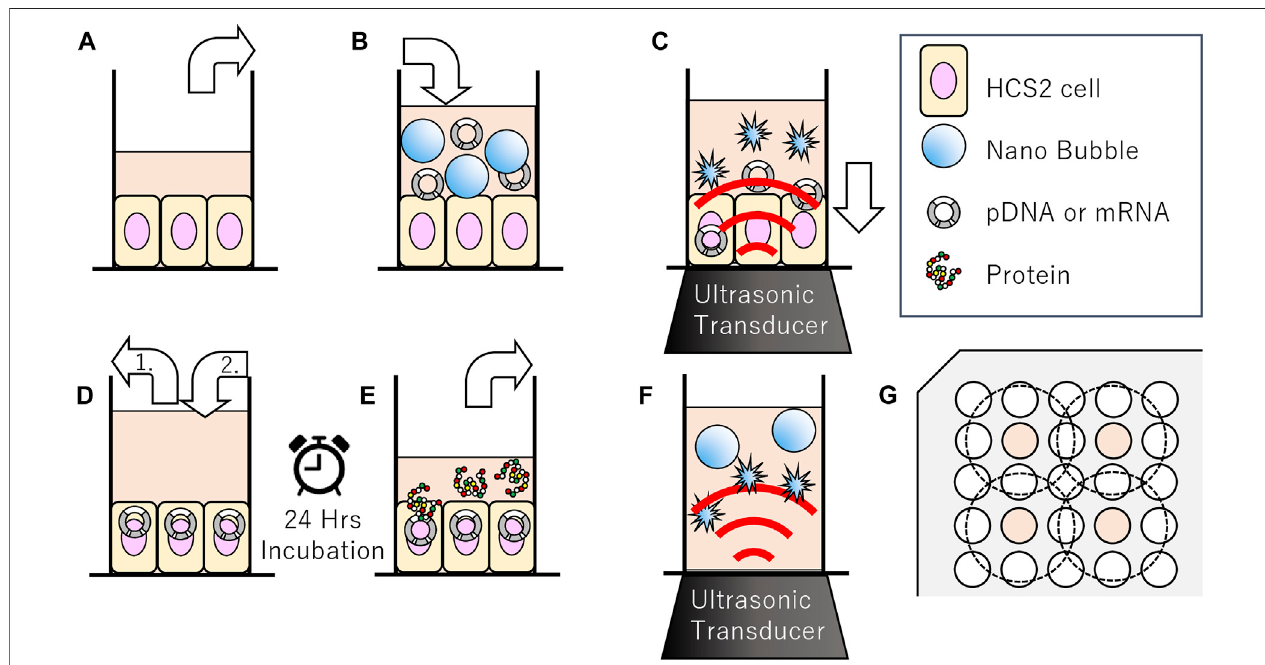
FIGURE 1 | Schematic representation of methods of sonoporation or sonication treatment to nanobubbles in 96-well plates. (A – E) Methods of sonoporation. (A) Removeincubationmediumfromwellof96multiwellplateseededwithHSC-2cells. (B) Fillwellswithmediumnanobubblesincluded. (C) Genetransfectionbyultrasonic irradiation. (D-1)Aspirationofsonicated medium (D-2)Addition newincubation medium. (E) After24 hincubation, collect supernatantforreporterassay. (F) Methods of sonication treatment to nanobubbles. Irradiation ultrasound to medium including nanobubbles. (G) Arrangement of wells seeded cells (indicated with color) and ultrasonic irradiation area (inside of dashed circle) on 96 multi-well